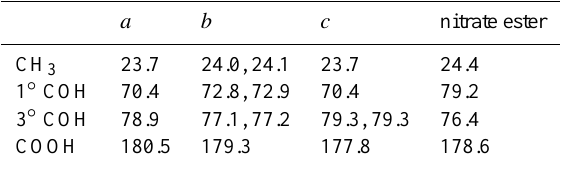
Table 5. 13 C NMR assignments for 2-MG and derivatives (in ppm, relative to DSS) for Solution 14. See Fig. 3 for key to labels of